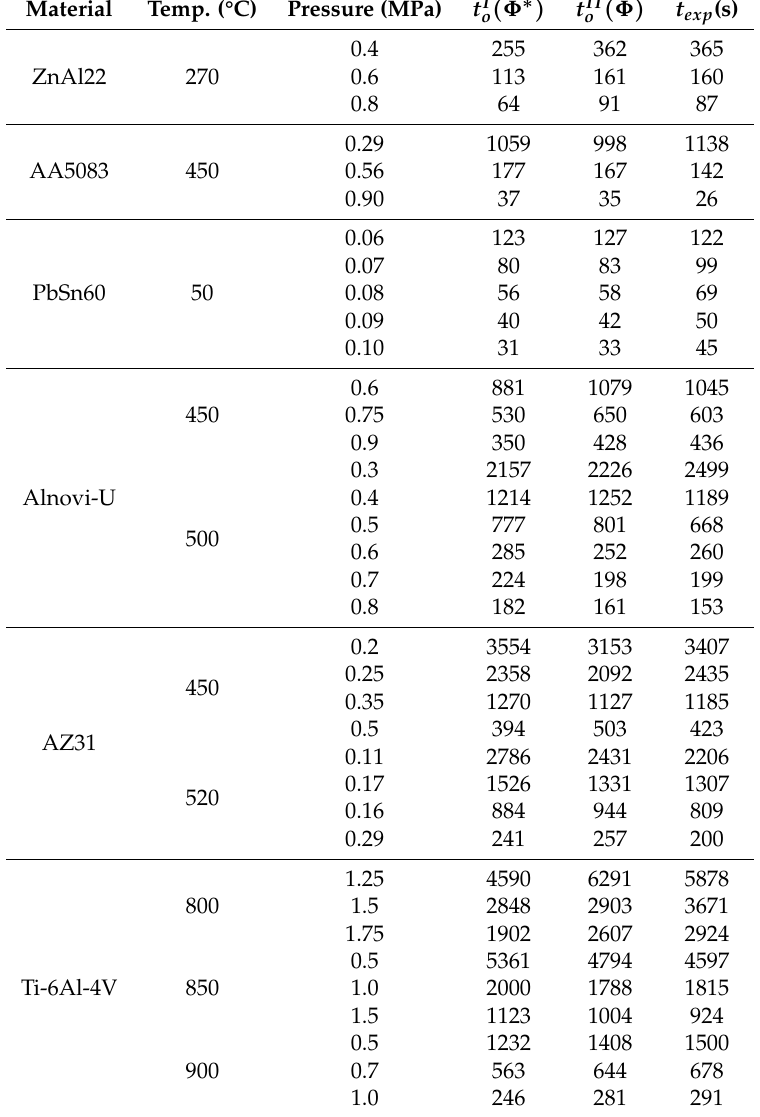
Table 3. Results of estimated forming time using (23) and (32) compared to the experimental forming